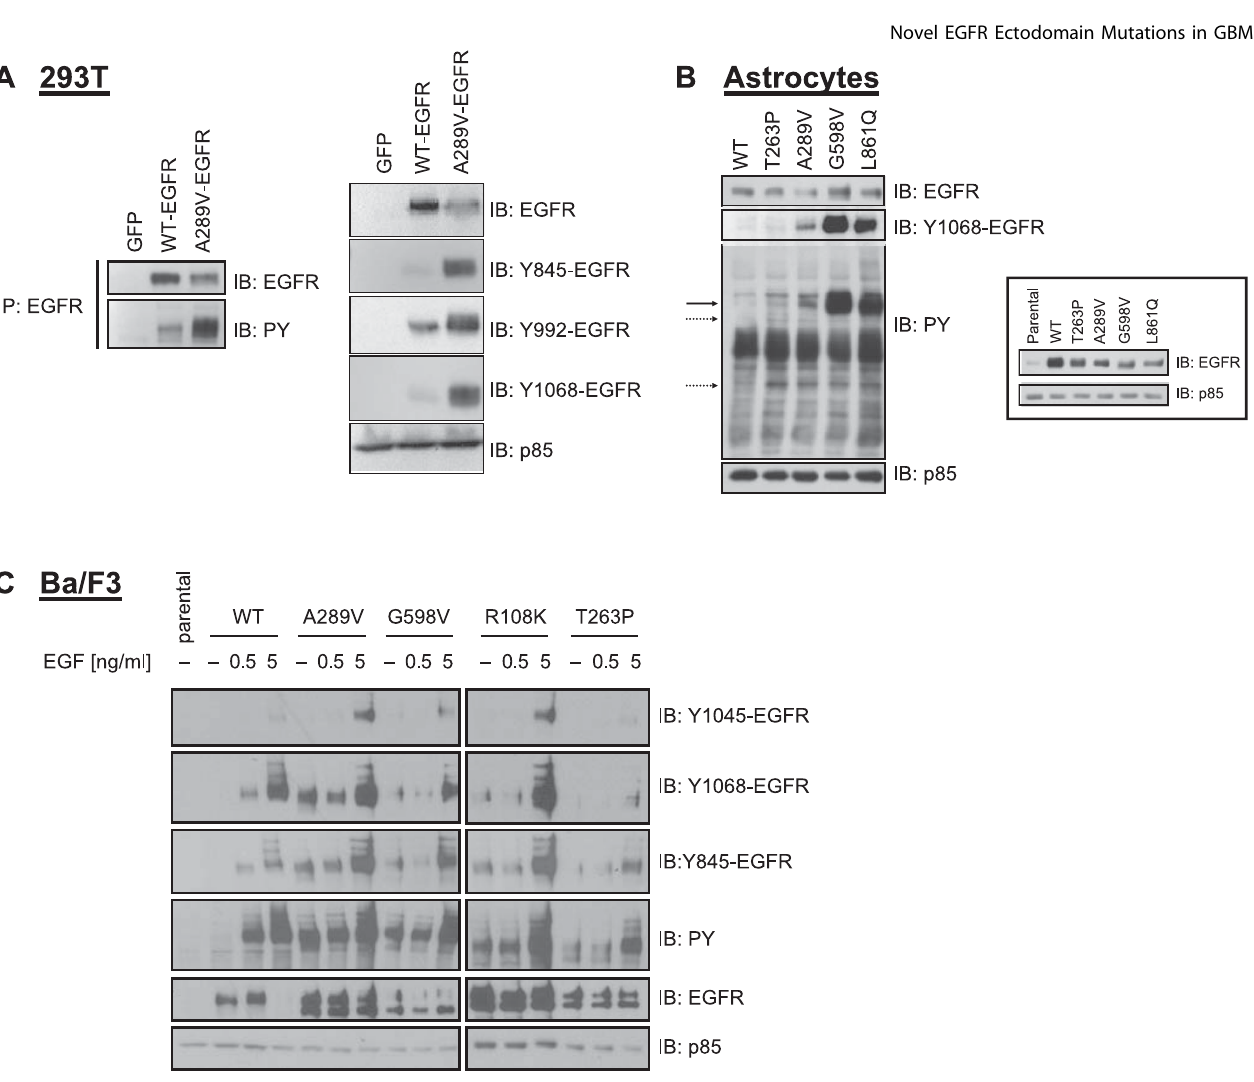
Figure 3. Basal Activation and Ligand Response of EGFR Ectodomain Mutants (A) Increased EGFR tyrosine phosphorylation of A289V-EGFR. 293T cells were transiently transfected with green fluorescent protein (GFP; control), wild- type EGFR , or A289V- EGFR . At 24 h after transfection, 24 cells were serum starved for 12 h and then lysed. Shown are immunoblots of immunoprecipitated EGFR (left blots) and whole cell lysates (right blots). (B) Increased basal activity of EGFR missense mutants in human astrocytes. Immortalized human astrocytes were stably infected with wild-type EGFR or the indicated EGFR missense mutants. Shown are total phosphotyrosine (PY), Y1068-EGFR, total EGFR, and PI3K p85 (loading control) immunoblots of whole cell lysates from cells following 12 h of serum starvation. The solid arrow at the PY position represents tyrosine-phosphorylated EGFR, and the interrupted arrows indicated other differentially tyrosine-phosphorylated proteins. The inset shows an anti-EGFR immunoblot of parental astrocytes (far-left lane) and stable astrocyte subclones (designated in remaining five lanes) growing in full serum. (C) Basal receptor phosphorylation and EGF-responsiveness of wild-type EGFR and four different EGFR ectodomain mutants stably expressed in Ba/F3 murine hematopoietic cells. Shown are immunoblots of stable Ba/F3 subclones after 12 h of serum starvation ( (cid:1) EGF) and 15 min following EGF- induction (0.5 or 5 ng/ml EGF).